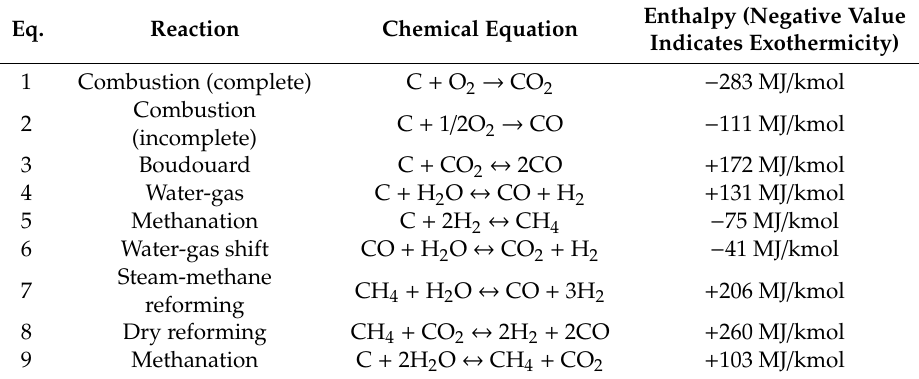
Enthalpy (Negative